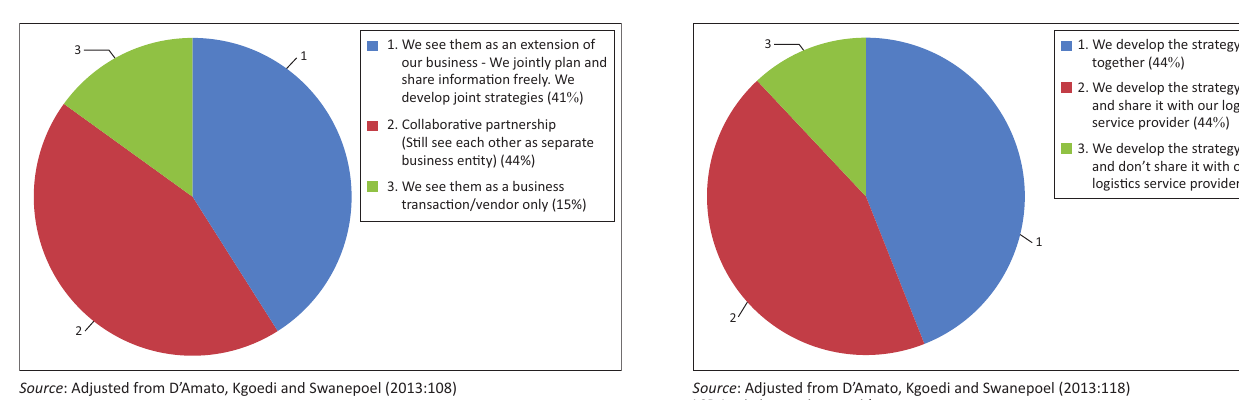
FIGURE 3: Closeness of outsourcing relationship.